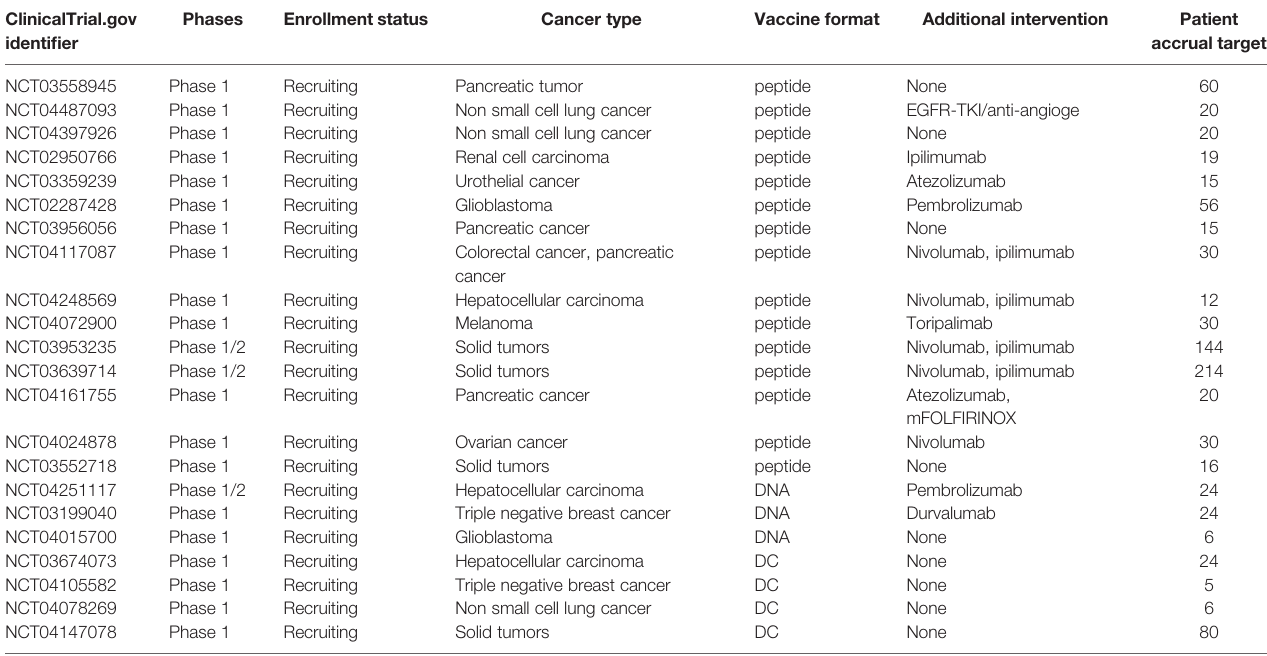
TABLE 1 | Clinical trials of neoantigen